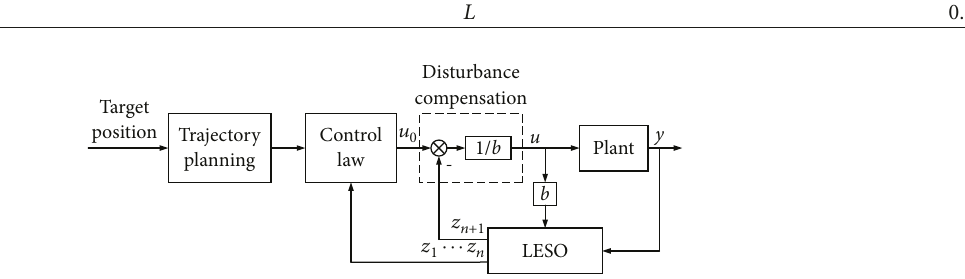
Figure 4: Structure of